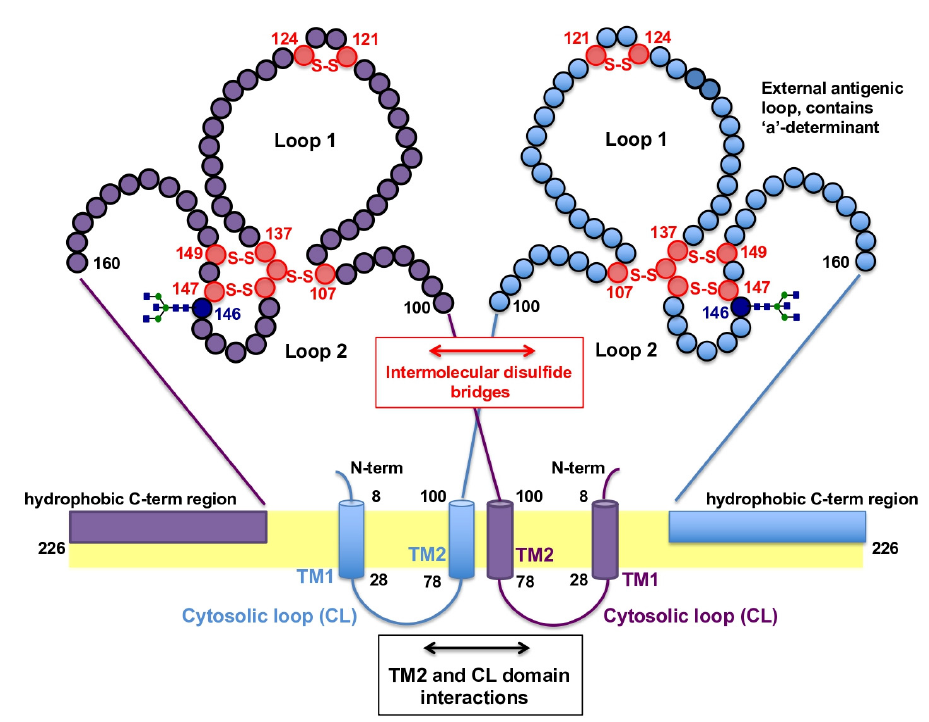
Figure 3. Proposed model for the formation of the HBsAgS homodimer based on Su ff ner et al. [57]. Dimerization of two HBsAgS monomers represented in purple and blue is facilitated by interactions of the transmembrane domains (TM2), cytosolic loops (CL) and intermolecular disulfide bridges (S-S) between cysteine residues (red circles) in the external loop region. The facultative N -glycosylation site at position N146 is indicated (dark blue). The orientation of the hydrophobic C-terminal region is illustrated in a simplified form.